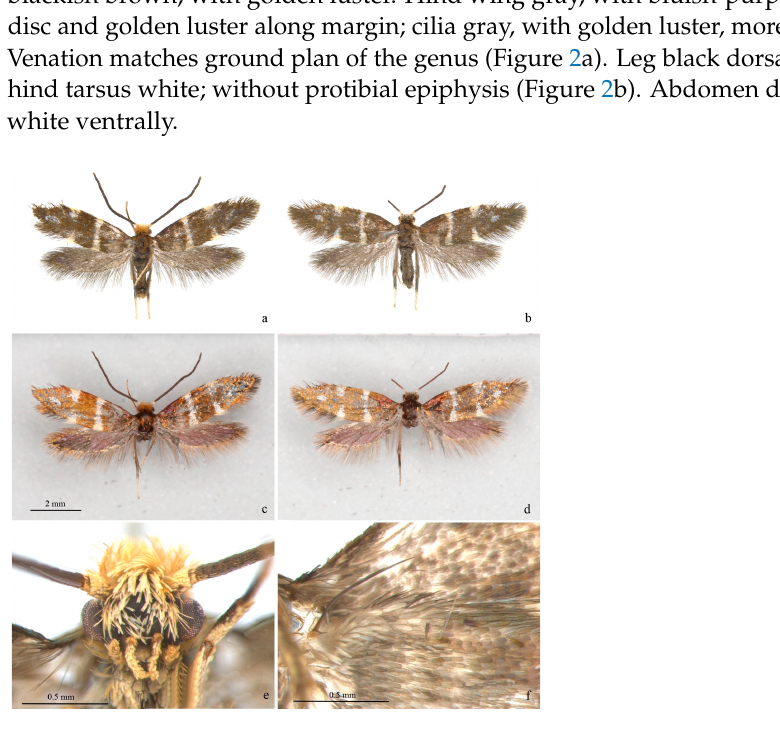
Figure 1. Adult of Subclemensia taigae . ( a ) Male, SDNU.Ent023846, photo taken under Leica M165C stereo microscope; ( b ) female, SDNU.Ent023848, photo taken under Leica M165C stereo microscope; ( c ) same specimen as ( a ), but taken under Canon EOS plus MP-E 65 mm lens to show metallic luster; ( d ) same specimen as ( b ), but taken under Canon EOS plus MP-E 65 mm lens to show metallic luster; ( e ) head, showing hair tuft on vertex and frons, maxillary palpus and labial palpus; ( f ) frenulum of male.